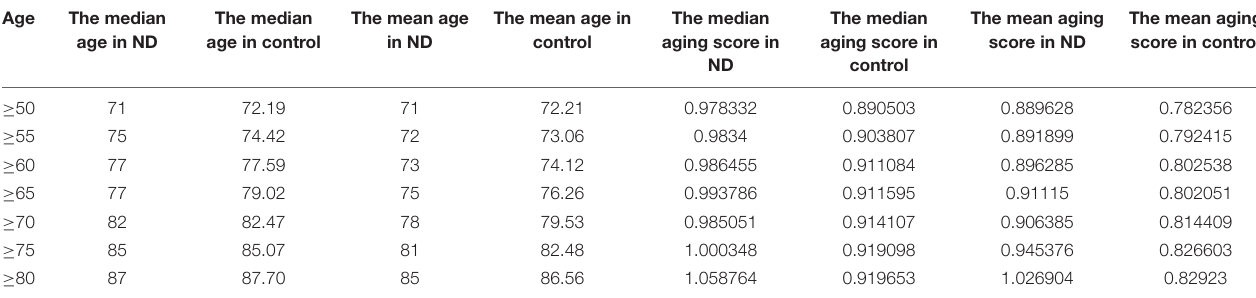
TABLE 3 | The chronological age and aging scores of ND and control in different age groups. Age The median The median age in ND age in